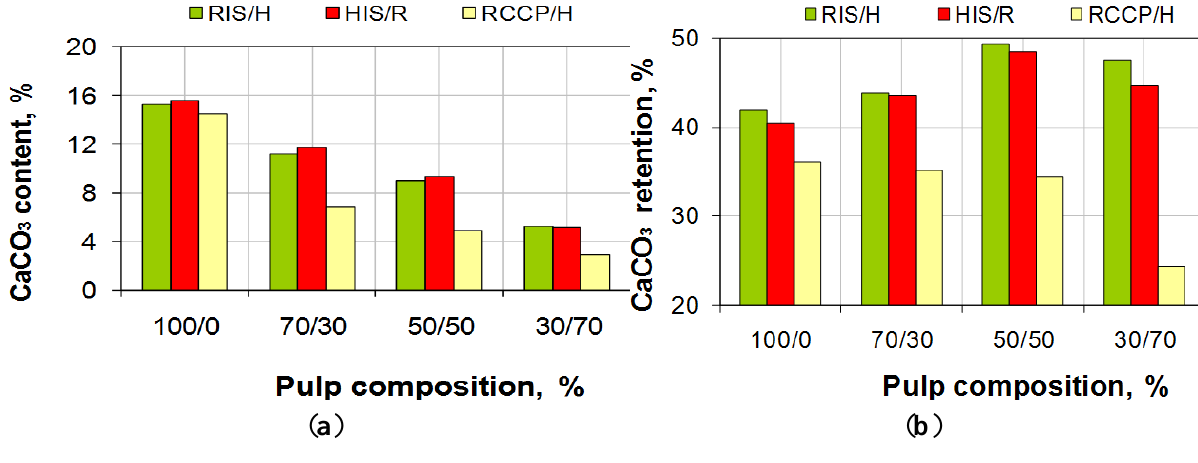
Figure 4. CaCO content ( a ) and retention level of CaCO 3